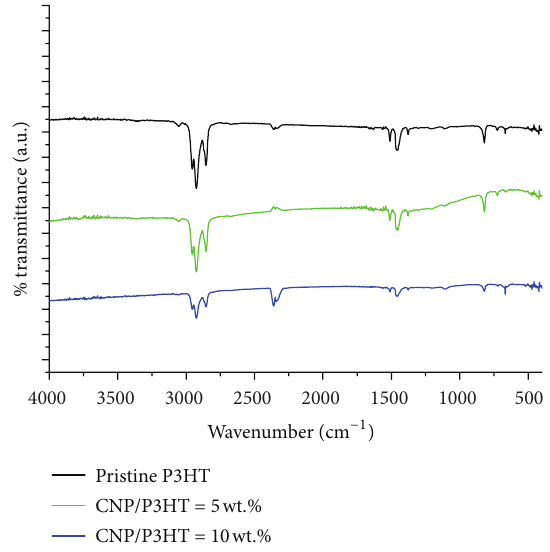
Figure 6: FTIR spectra of pristine P3HT, CNP/P3HT = 5wt.%, and CNP/P3HT = 10wt.% thin films.